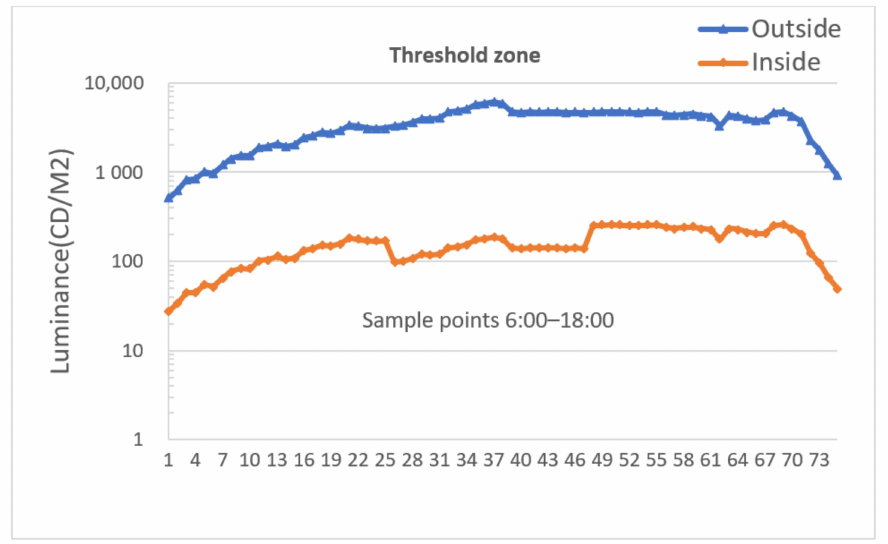
Figure 10. Luminance curve in a threshold